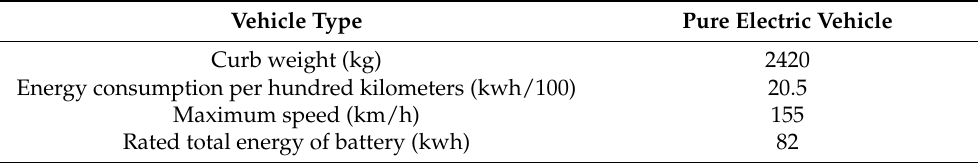
Table 1. Specific parameters of the vehicle.